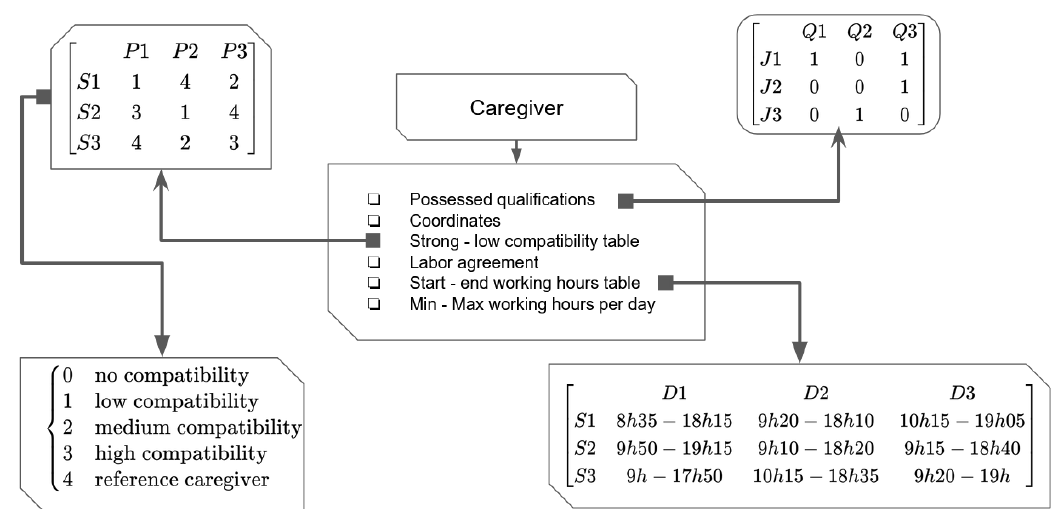
Figure 6. Description and summary of a